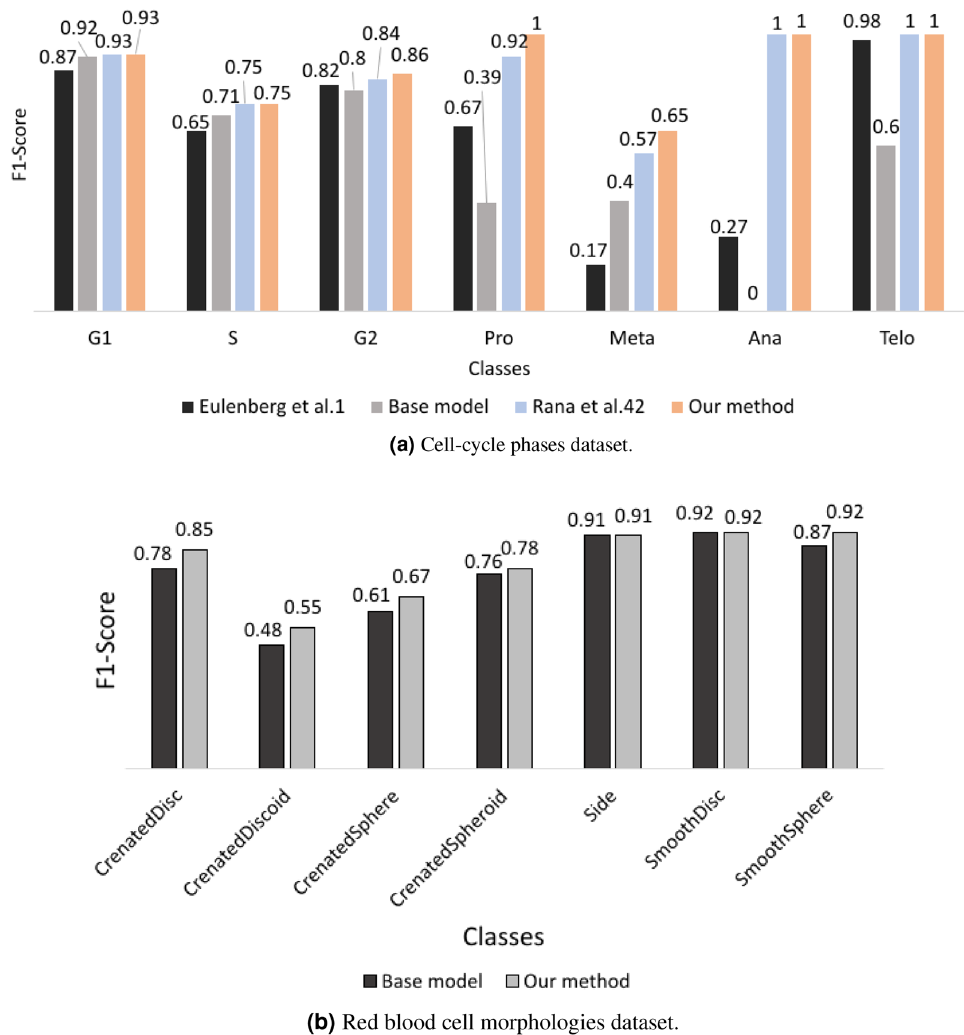
Figure 7. Comparing per-class F1 scores with base model and existing studies on same dataset.